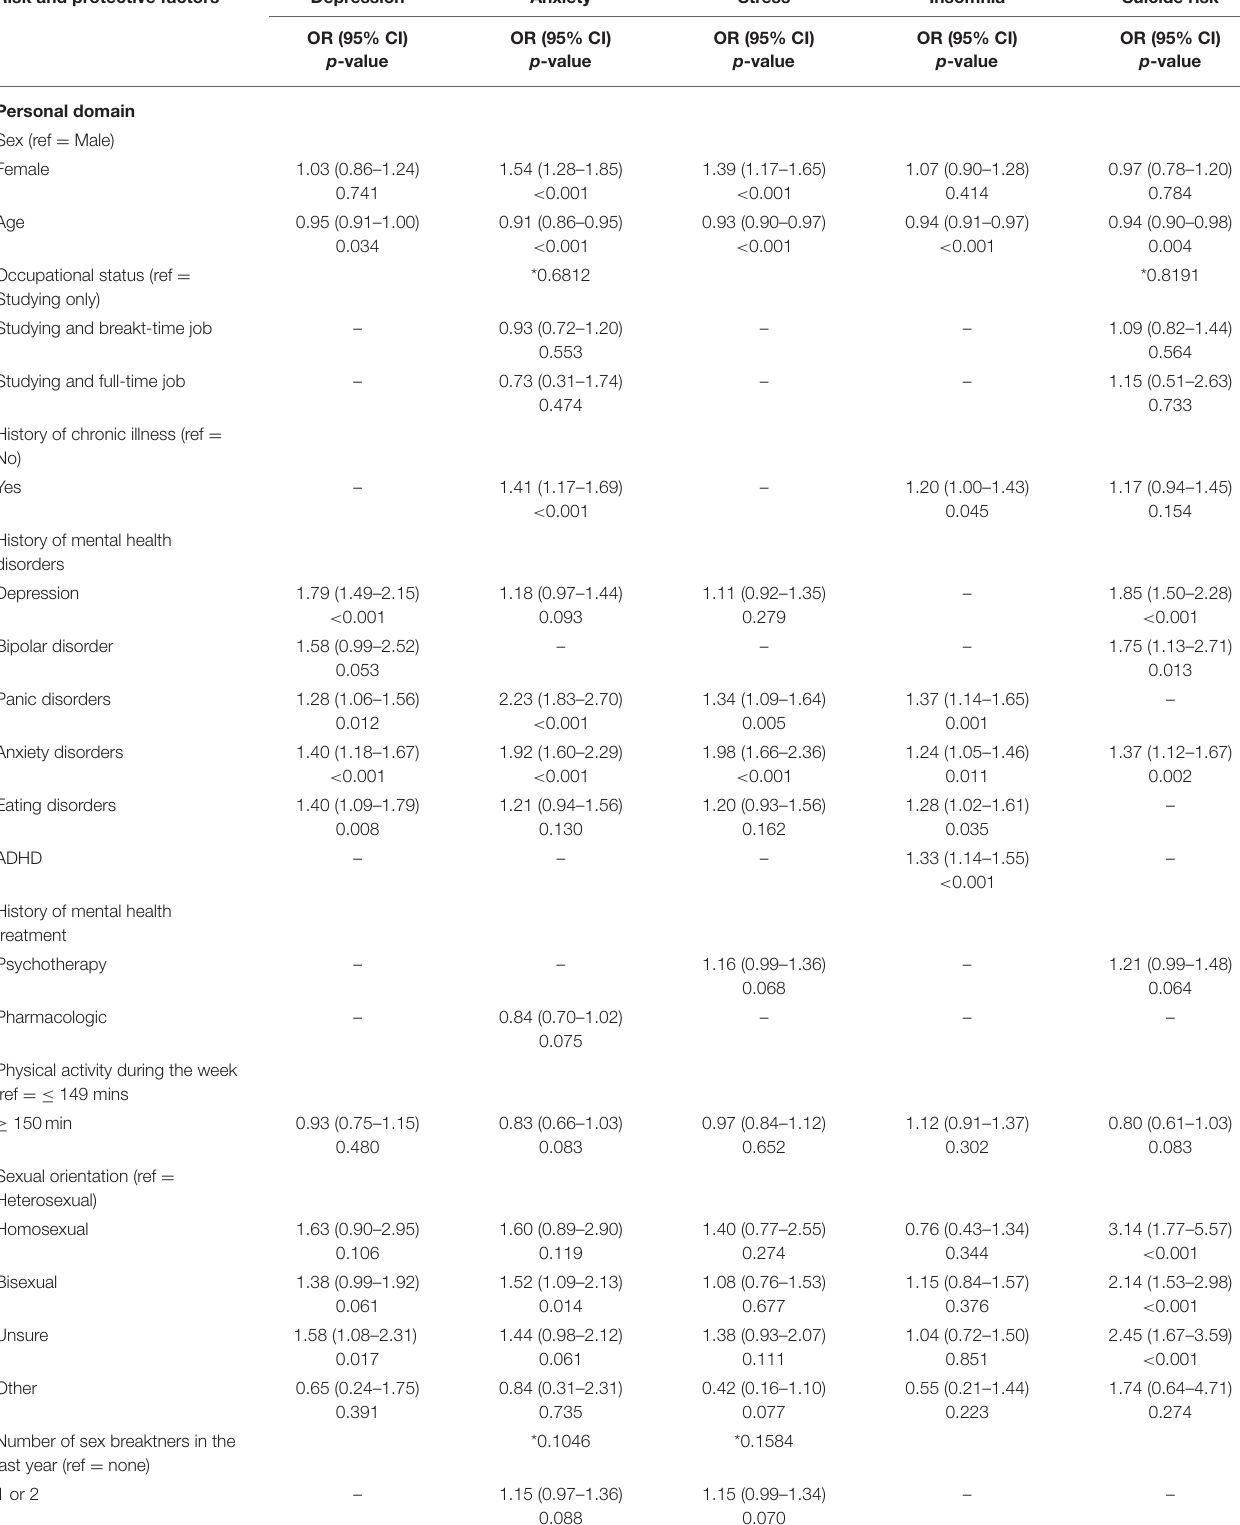
TABLE 7 | Final multivariable associations between risk and protective factors and the outcomes depression, anxiety, stress, insomnia, and suicide